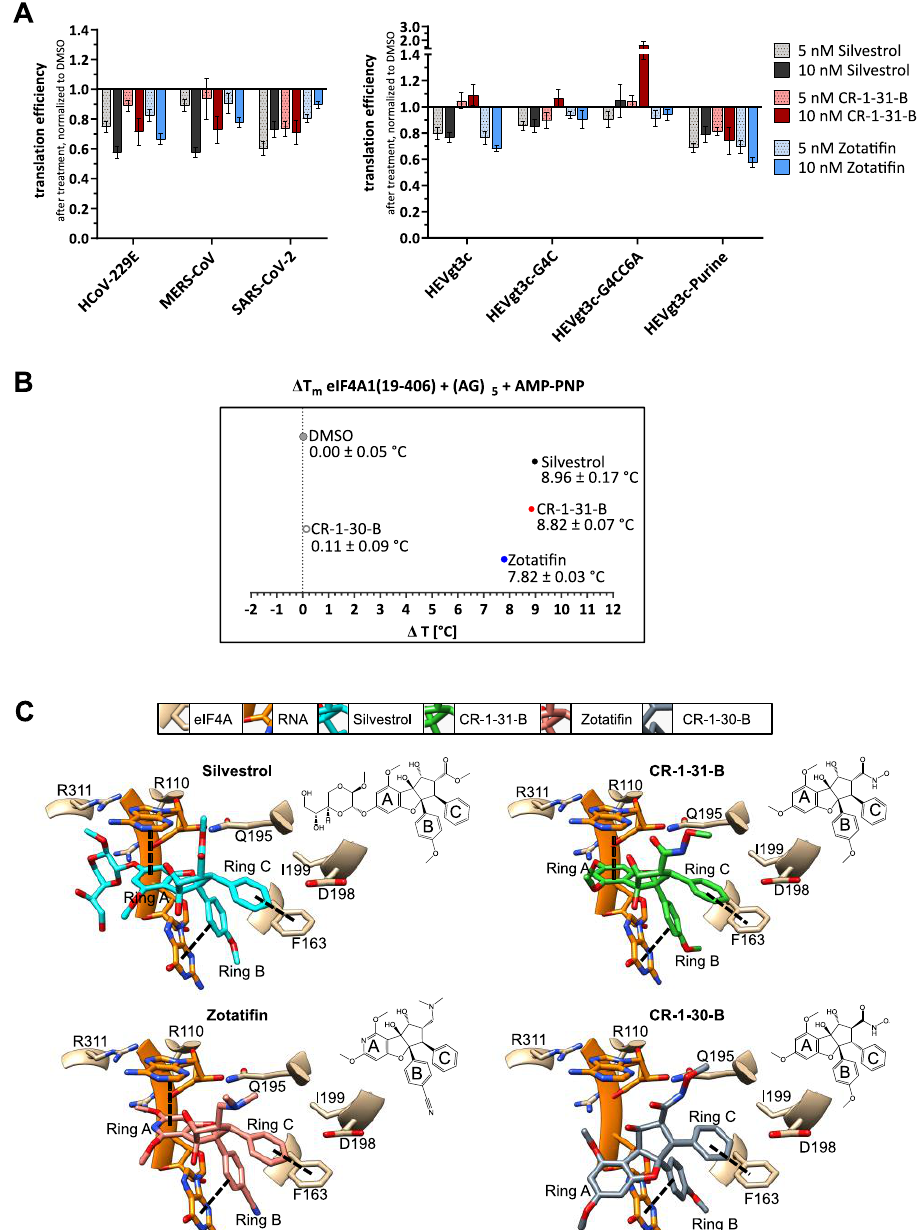
Figure 3. Translation inhibition, thermal shift assay and docking of silvestrol, CR-1-31-B and zotatifin. ( A ) Comparison of the inhibitory effects of silvestrol, CR-1-31-B and zotatifin on reporter gene expression constructs containing 5 (cid:48) -UTRs from coronaviruses HCoV-229E, MERS-CoV and SARS- CoV-2 and analyses of the 5 (cid:48) -UTRs of hepatitis E virus genotype 3c (HEVgt3c) and derivatives thereof with regard to their sensitivity towards silvestrol, CR-1-31-B and zotatifin treatment. Reporter gene expressions were normalized to transfection efficiencies and DMSO controls ( n ≥ 3). Error bars show SEM. For predicted RNA secondary structures of HEVgt3c 5 (cid:48) -UTR and the respective variants, see Supplementary Figure S1 ( B ) Melting temperature of the eIF4A-polypurine RNA (AG) 5 -AMP-PNP complex in the presence of silvestrol, CR-1-31-B, zotatifin or the inactive enantiomer CR-1-30-B or DMSO to compare the binding affinities of rocaglates to eIF4A-RNA complexes. Numbers indicate the temperature shift compared to DMSO control ± SEM for n ≥ 3. ( C ) Predicted binding modes of silvestrol, CR-1-31-B, zotatifin and CR-1-30-B (inactive enantiomer of CR-1-31-B) to the human eIF4A-polypurine RNA (AG) 5 complex (PDB: 5ZC9) using AutoDock